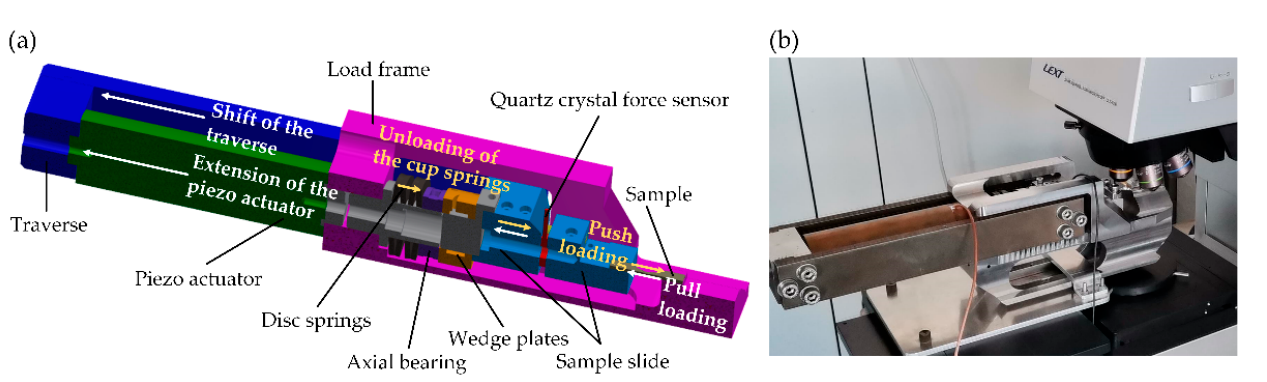
Figure 2. ( a ) Design and functional principle of the miniaturized testing device; ( b ) Installation of the miniaturized testing device into the confocal laser microscope.